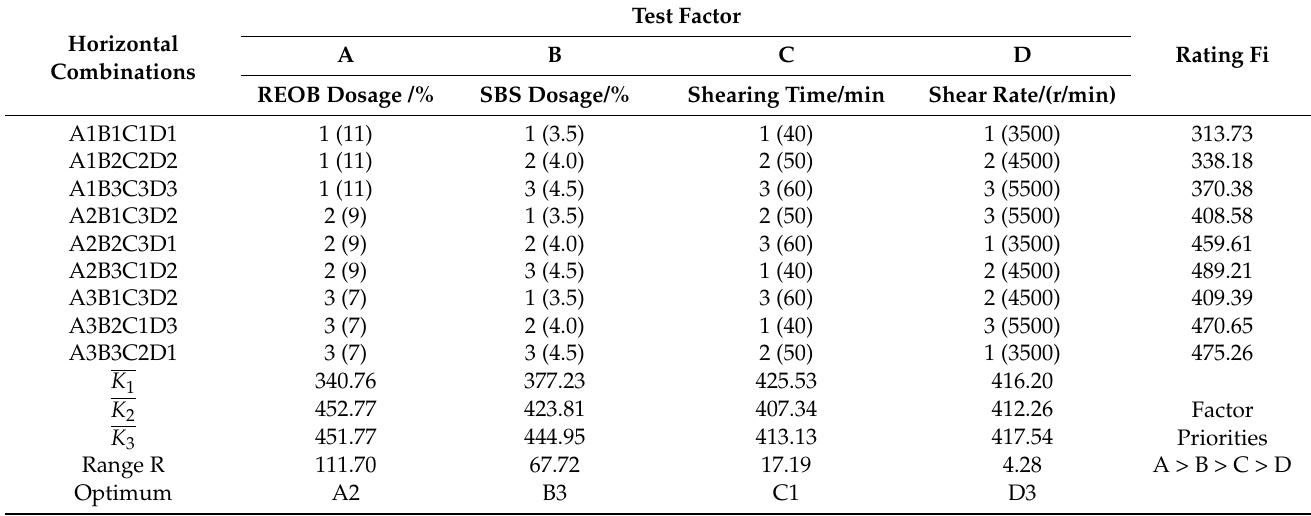
Table 6. Gray correlation composite score and extreme difference analysis